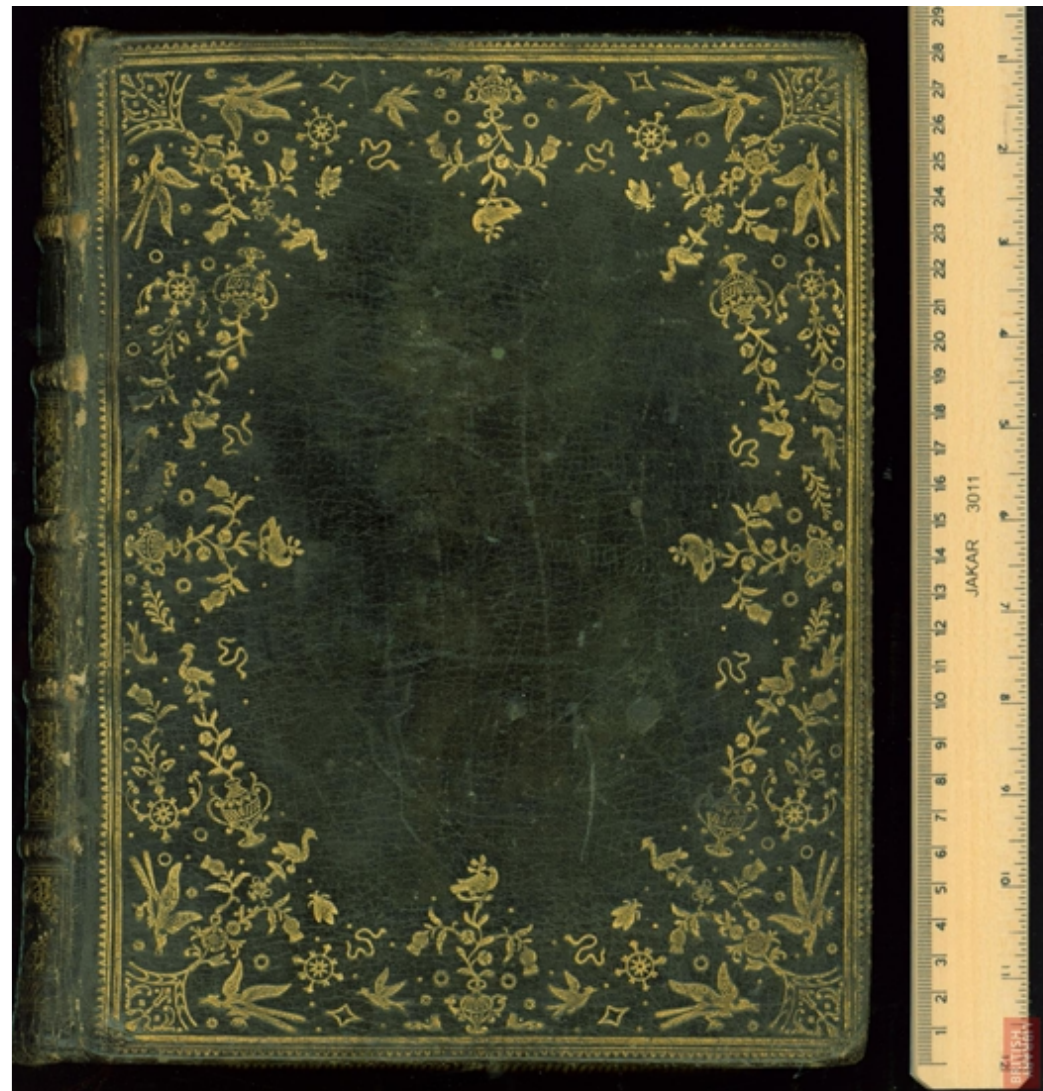
Fig. 22. The Historical Part of the Holy Bible ... Engraven by John Sturt, from designs of the greatest masters [London, 1730?]. This is finished with the same tools used by Kenrick Peck’s binder. BL, C.108.f.15(1.).